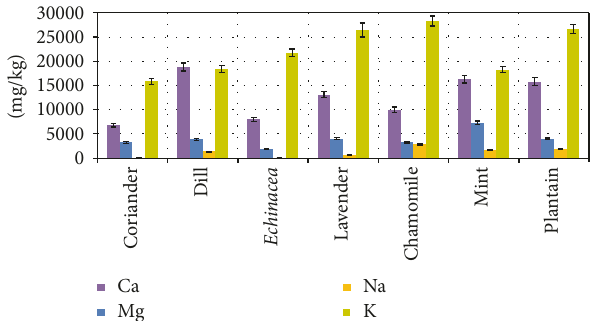
Figure 1: Selected macroelement (K, Ca, Mg, and Na) content in the plant